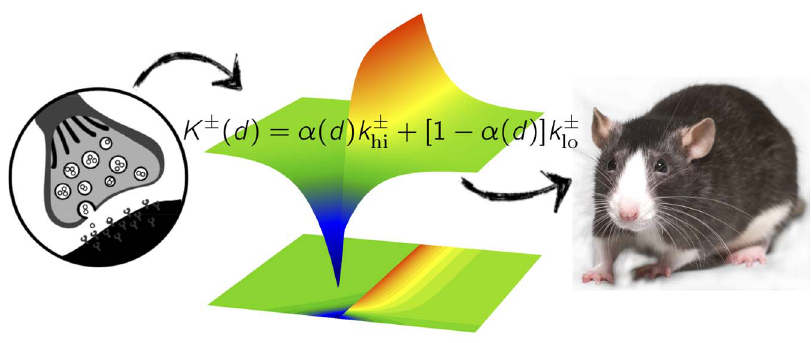
Fig. 1. Learning how to make decisions: a computational model bridges the gap between the intricate subtleties of individual neuronal connections and the behavior of the whole animal. Image credit: Left: Iwan Gabovitch, openclipart; Center: Kevin Gurney; Right: Alexey Krasavin,